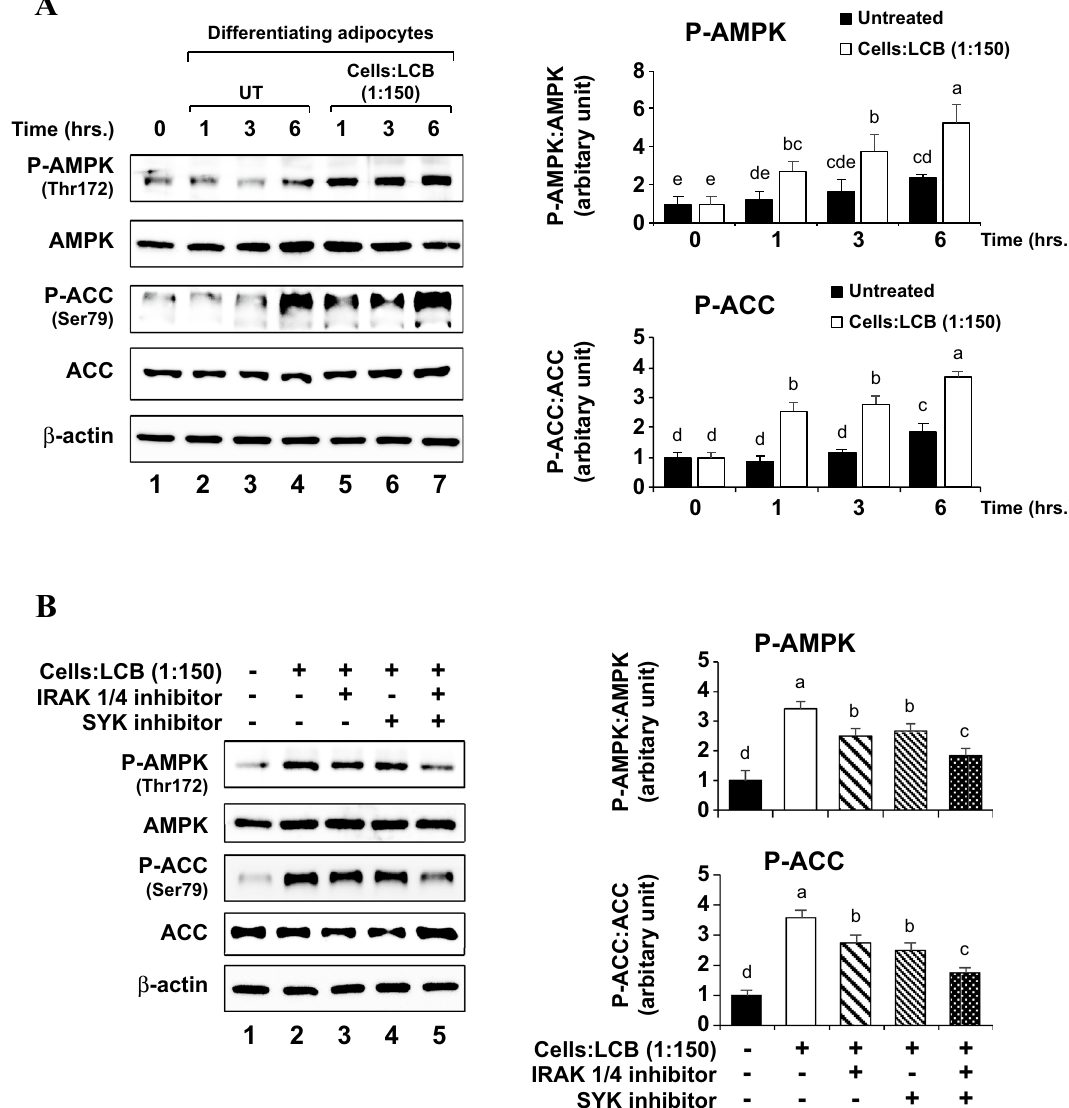
Figure 7. LCB activates AMPK and ACC proteins at the early stage of adipogenesis. (A) shows a representative data set for Western blotting assay performed using anti-phospho AMPK (Thr172), anti-AMPK (total), anti-phospho ACC (Ser79), anti-ACC (total), and anti-β-actin antibodies. The D/A medium, which initiates adipogenesis, was added to the cells without or with LCB (1:150 cells:LCB). Treatment was performed for 0, 1, 3, and 6 h prior to harvesting the cells for Western blot analysis. Western blotting with β-actin was performed as a loading control. The protein expression is calculated from the protein:β-actin ratio from each treatment and expressed as the relative ratio in respect to the ratio from preadipocytes data shown in lane 1. (B) shows a representative data set for Western blotting assay performed using the same set of the antibodies described in (A) . Preadipocytes were pre-treated with either 10 μM IRAK 1/4 or 10 μM SYK inhibitors for 30 min. Then, the D/A medium together with LCB (1:150 cells:LCB) in the absence or the presence of each inhibitor or both were added to the cells, and the incubation was performed for 3 h before harvesting the cells for Western blot analysis. The protein expression analysis was performed as described in (A)